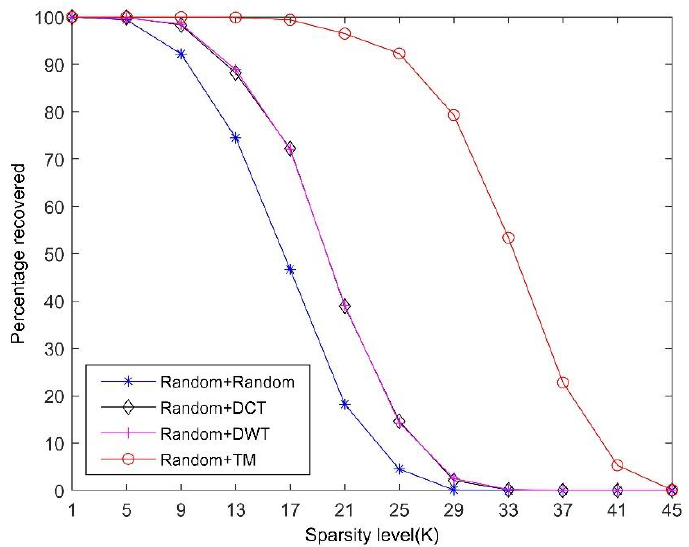
Figure 6. Comparison of the reconstruction performances using different sparsifying dictionaries under the same random measurement matrix ( M = 64).